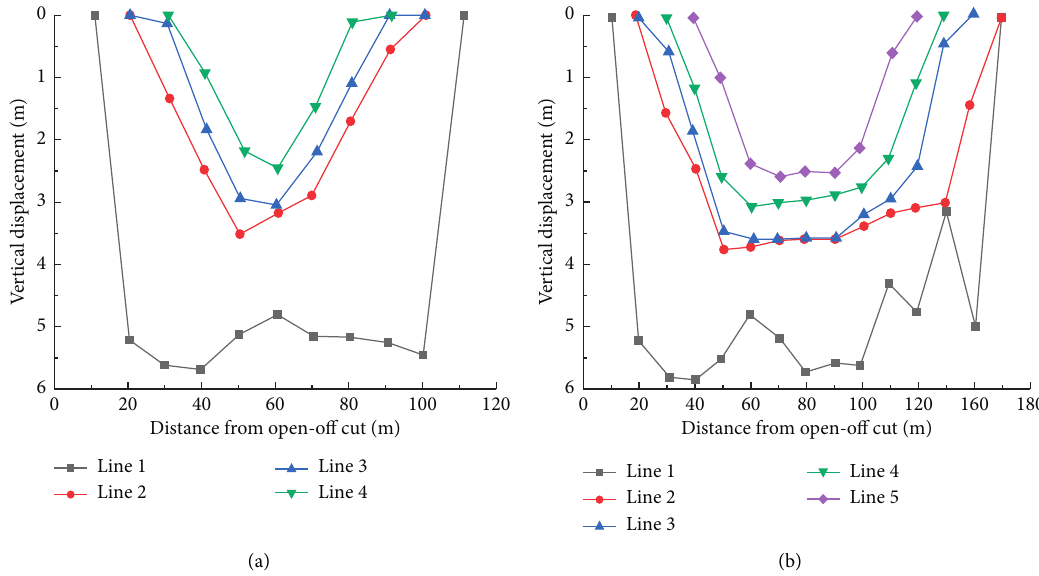
Figure 3: Vertical displacement curve of overlying strata during working face advancing. (a) Working face advancing 85 meters. (b) Working face advancing 135